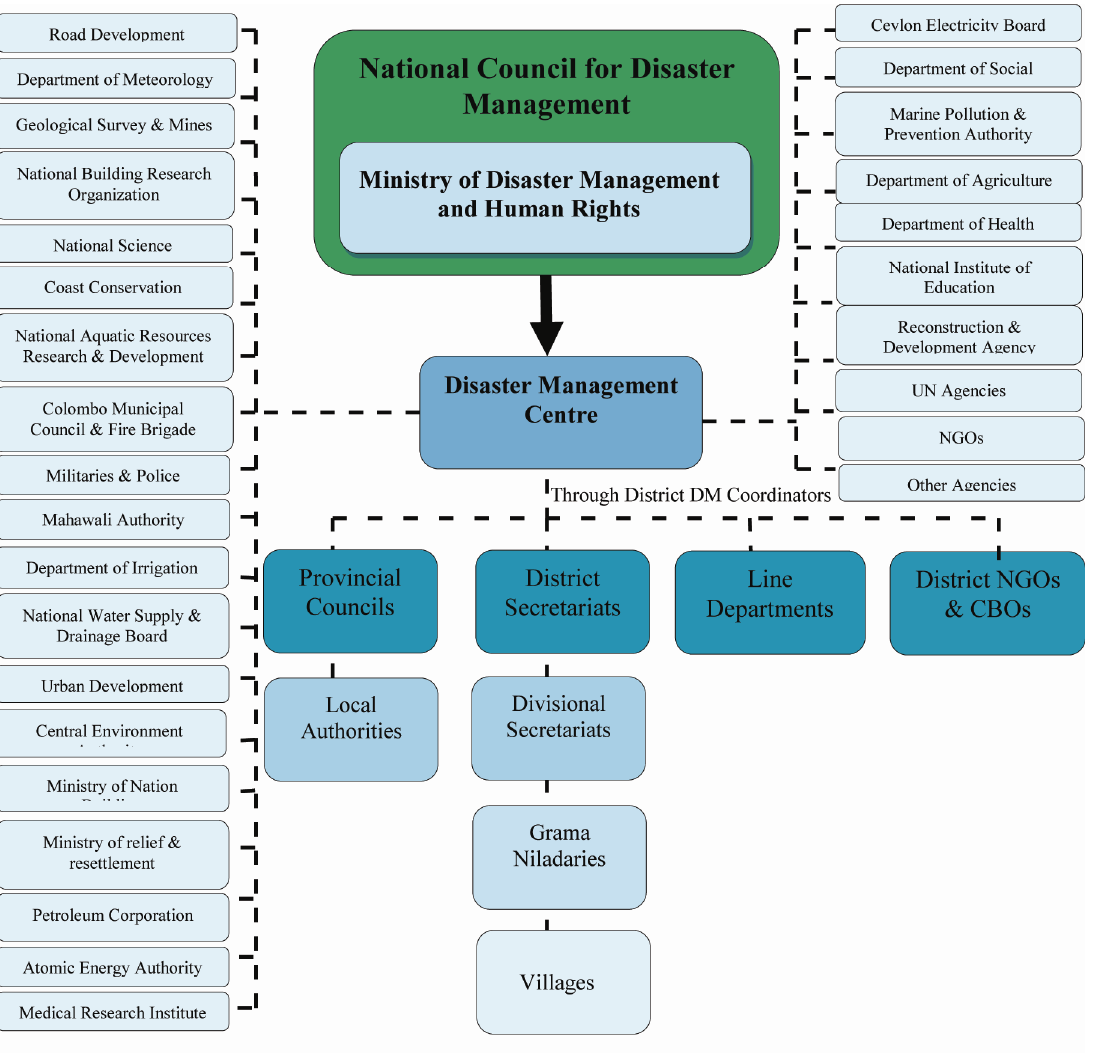
Fig. 1. The institutional framework for disaster management (DMC 2005,